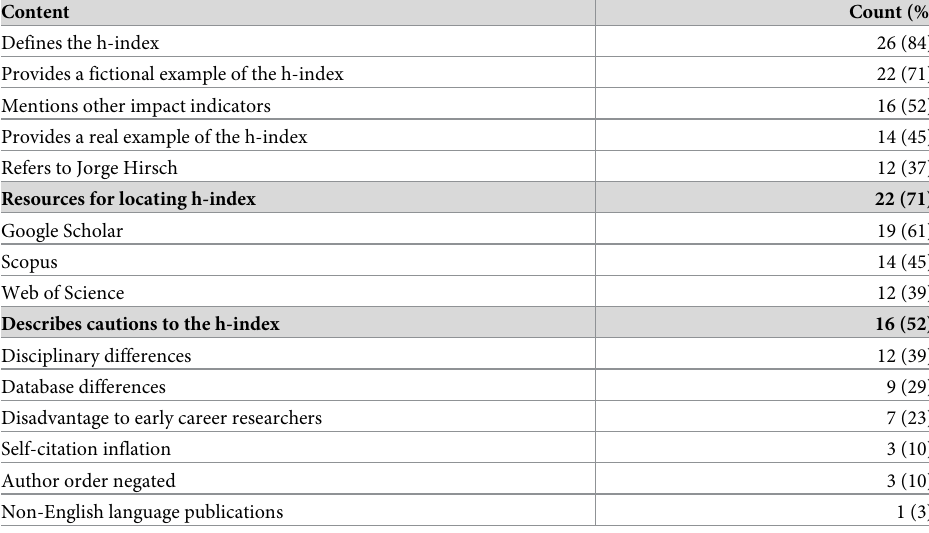
Table 2. A summary of the content of short YouTube videos on the h-index (n =